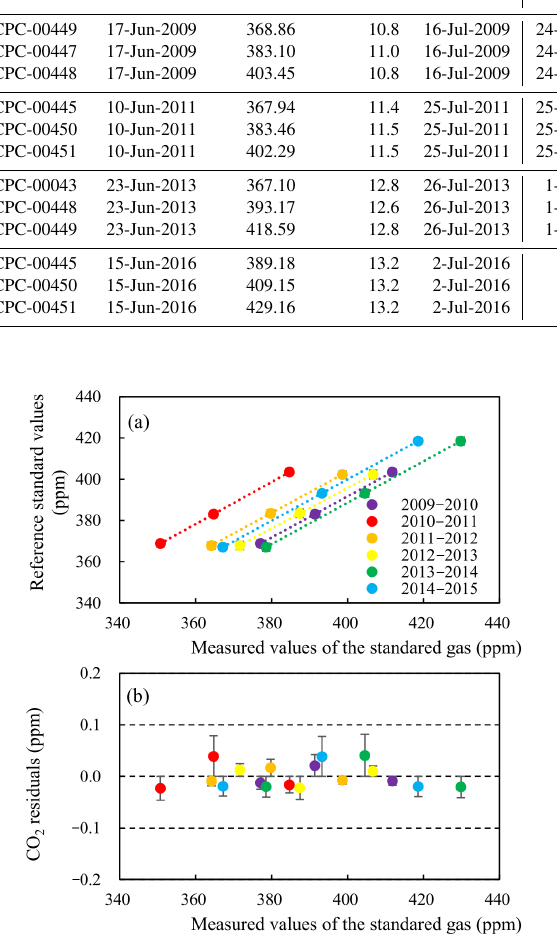
Figure 4. (a) Linearity tests between the apparent measured val- ues of the standard gas and the reference standard values (assigned values), and (b) CO 2